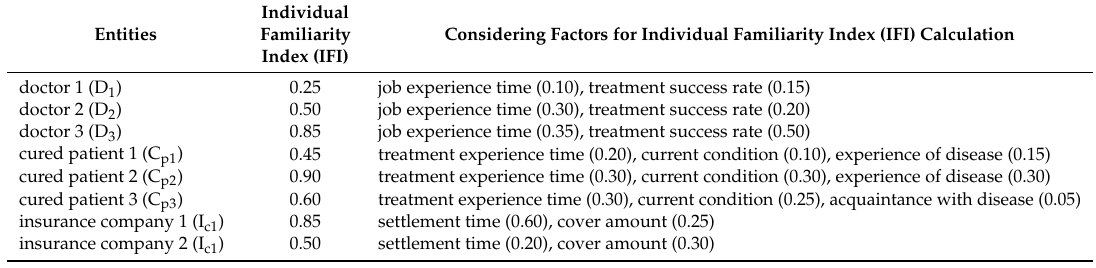
Table 4. Individual familiarity indexes (IFI) used in running example.